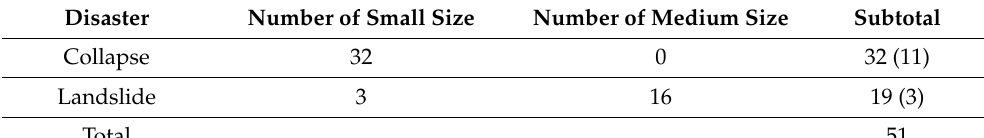
Table 2. Information of collapses and landslides in the study area. Disaster